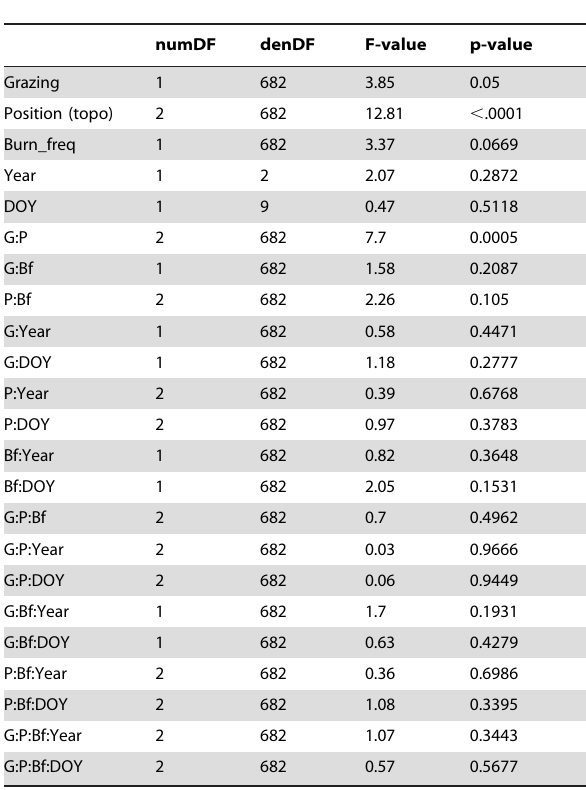
(Table 2, Fig. 2), despite the varying climate histories from 2008–